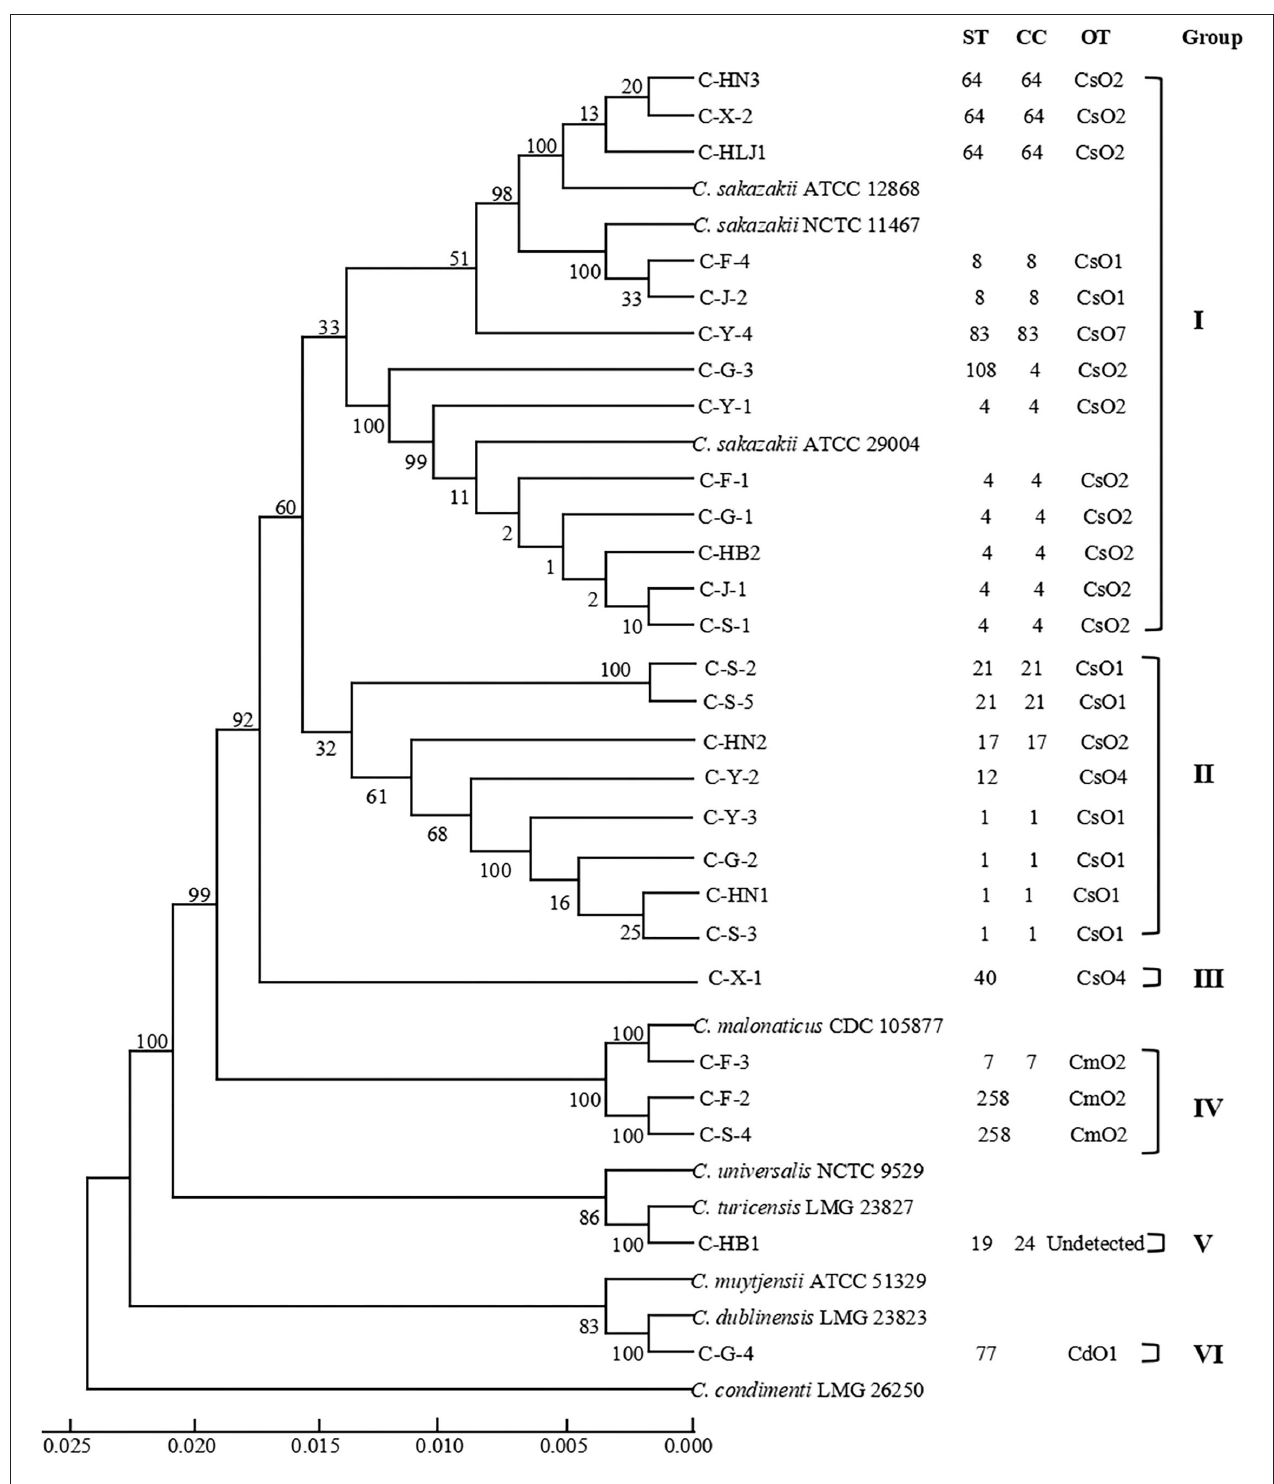
FIGURE 1 | Phylogenetic relationship of 27 Cronobacter isolates containing 14 STs. The UPGMA tree based on 7 loci was constructed using MEGA7.0, with 1,000 bootstrap replicates. The Cronobacter sakazakii ATCC 29544, C. sakazakii ATCC BAA-894, C. sakazakii ATCC 29004, C. sakazakii ATCC 12868, Cronobacter malonaticus CDC 105877, Cronobacter dublinensis LMG 23823, Cronobacter turicensis LMG 23827, Cronobacter universalis NCTC 9529, Cronobacter condimenti LMG 26250, and Cronobacter muytjensii ATCC 51329 were used as the reference strains. Detailed information about each strain is added, including ST, CC, OT, and